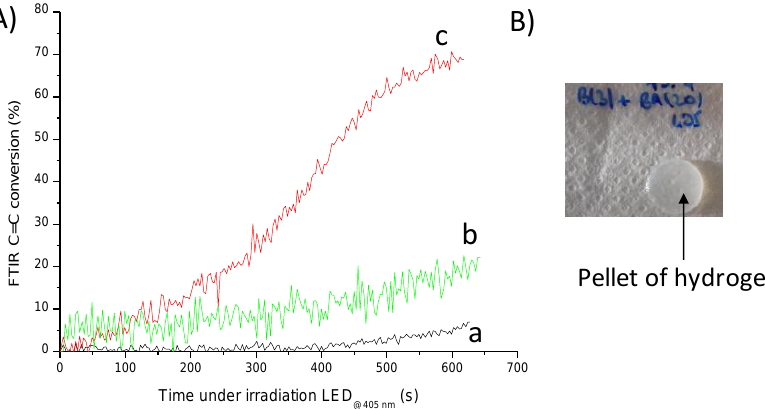
Figure 5. ( A ) Photopolymerization profiles (methacrylate function conversion vs. time) for a 1.4 mm-thick PEGDA/ETPT (2:1 w / w ) acrylate resin under air, with a 405 nm LED irradiation (20 mW/cm²), initiated by different Type I PIs in combination with 4 ( w / w ): (a) Irgacure 2959 (1% w / w ) and 4 (2% w / w ), (b) 1 (1% w / w ) and 4 (2% w / w ), and (c) 2 (1% w / w ) and 4 (2% w / w ). ( B ) Picture of the hydrogel obtained from c after 590 s irradiation.